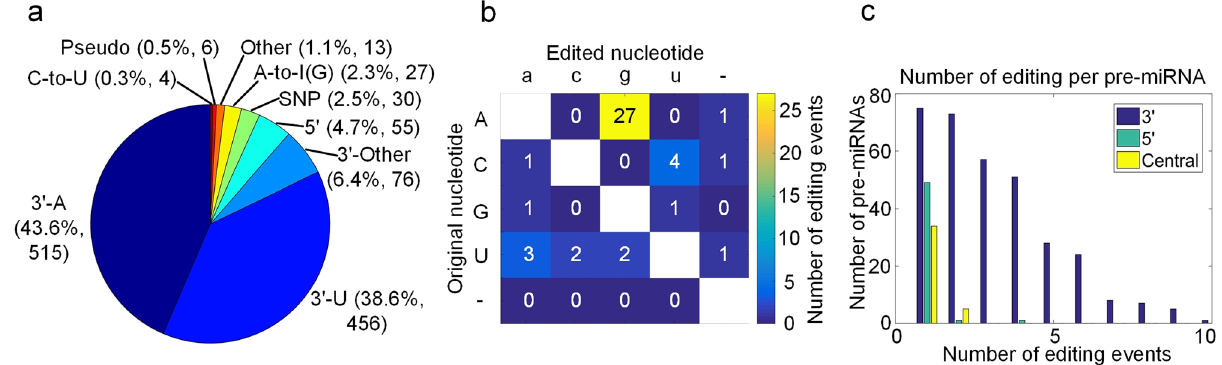
Figure 1. A summary of miRNA mutation and editing sites. ( a ) The categories of significant M/E sites in miRNAs. ( b ) The numbers of different types of editing sites in the central regions of miRNAs. ( c ) The distributions of the numbers of pre-miRNAs with editing events happened at 3’-, 5’-ends and central regions of mature Table S4). According to the TPTM (Tags Per Ten Million sequencing reads) and M/E editing percent of these 27 A-to-I editing sites, 6 highly edited sites were found, which were hsa-mir-411_20_A_g, hsa-mir-381_52_A_g,